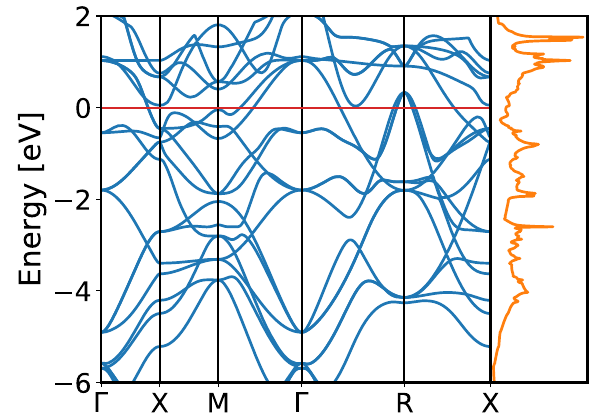
Fig. 6 Calculated band structure (left) and total density-of-states (right) for MoNMn 3 . The red line represents the Fermi level.